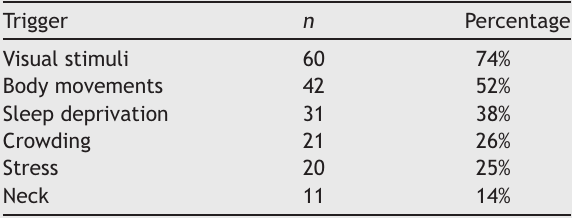
Main triggers in the onset of symptoms of persis- tent postural and perceptual dizziness no lugar de chronic subjective dizziness.